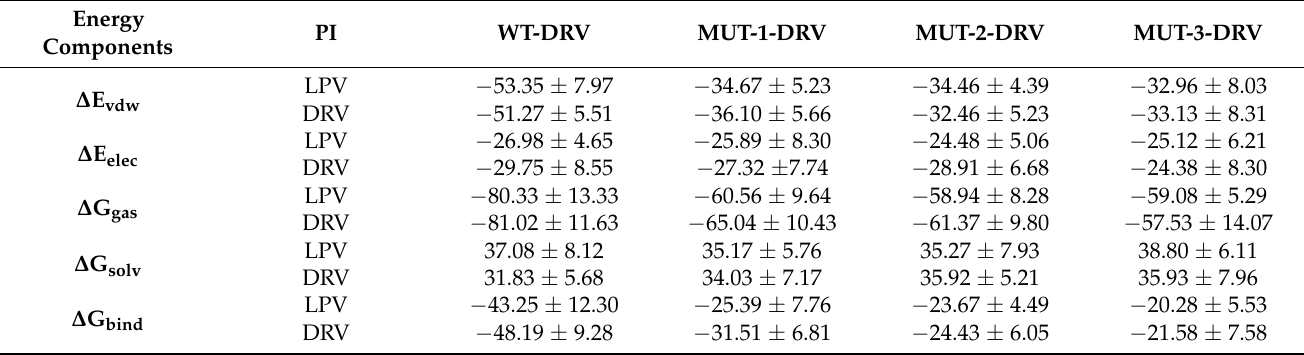
Table 3. Binding free energies of DRV and LPV to HIV-1 PR variants. Energy